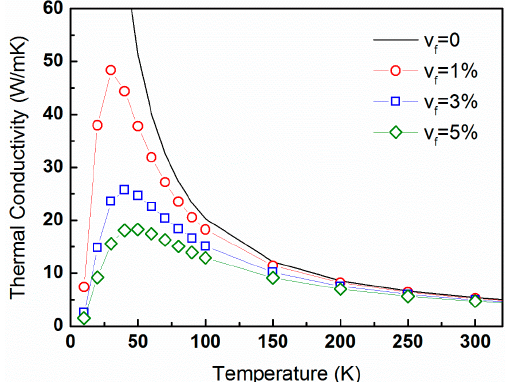
Figure 4. The temperature-dependent lattice thermal conductivity of PbTe calculated from expression (16) for the temperature range of 0 through 300 K and a constant precipitate size distribution characterized by R o = 30 nm and ∆ R = 5 nm, and for volume fractions of 0%, 1%, 3%, and 5% denoted by the black line, red circles, blue squares, and green diamonds, respectively.